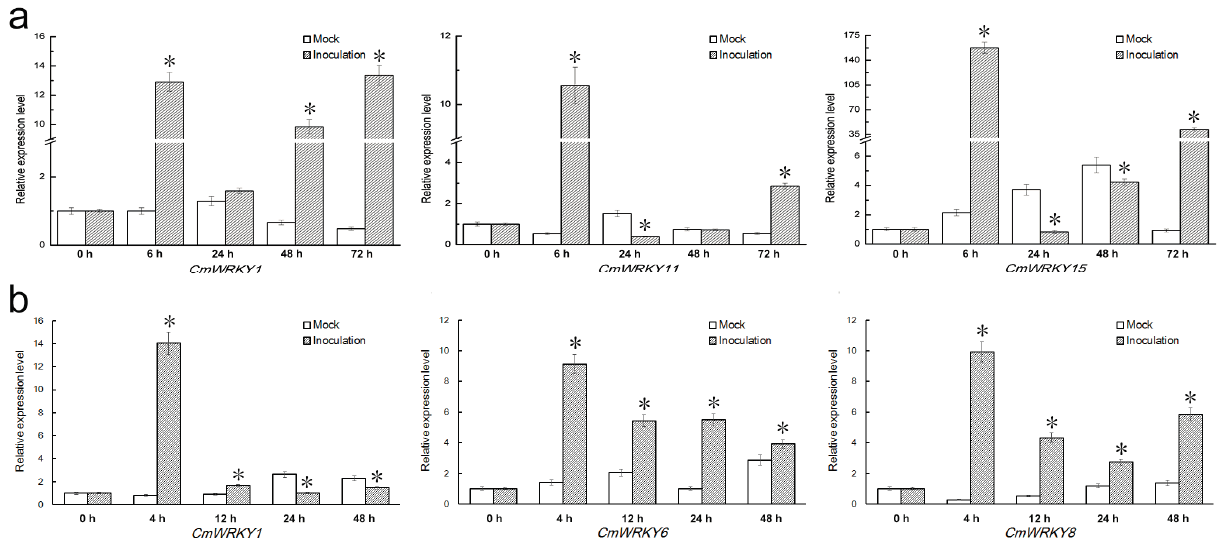
Figure 6. Differential expression patterns of the CmWRKY genes in leaves to biotic stress. ( a ) inoculation with A. tenuissima ; ( b ) inoculation with F. oxysporum ; ( c ) inoculation with P. horiana ; and ( d ) infestation with the aphid M. sanbourni . Asterisks indicate significant differences ( p < 0.05) between treatment and control